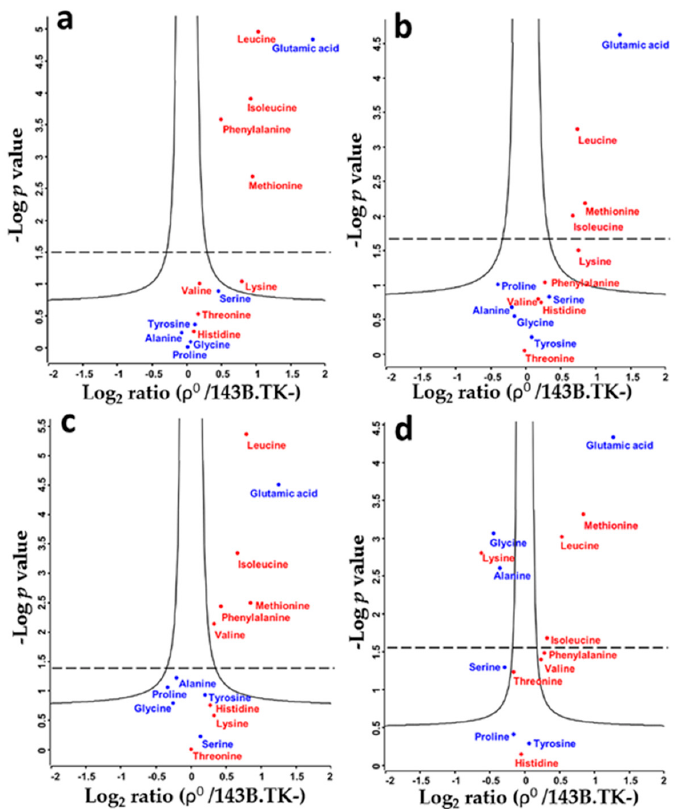
Figure 2. Volcano plots of relative amino acid levels between ρ 0 and 143B.TK- cells after switching the culture medium from unlabeled to labeled amino acids at different time points. Shown are 13 C 15 N amino acid ratios at ( a ) 2.5 min, ( b ) 5 min, ( c ) 10 min, and ( d ) 20 min. Significantly altered amino acids are above the continuous line and in addition after Benjamini-Hochberg (BH) correction above the dashed line. Essential amino acids are in red.